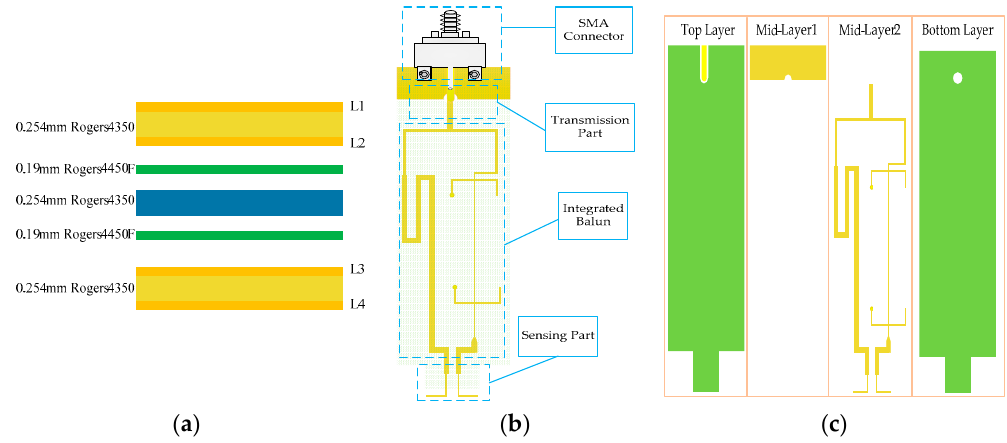
Figure 5. Detailed structure of the tangential electric-field sensor. ( a ) Stack-up; ( b ) overall top view; and ( c ) top view of each layer, to clearly exhibit the internal connections of the tangential electric-field sensor.